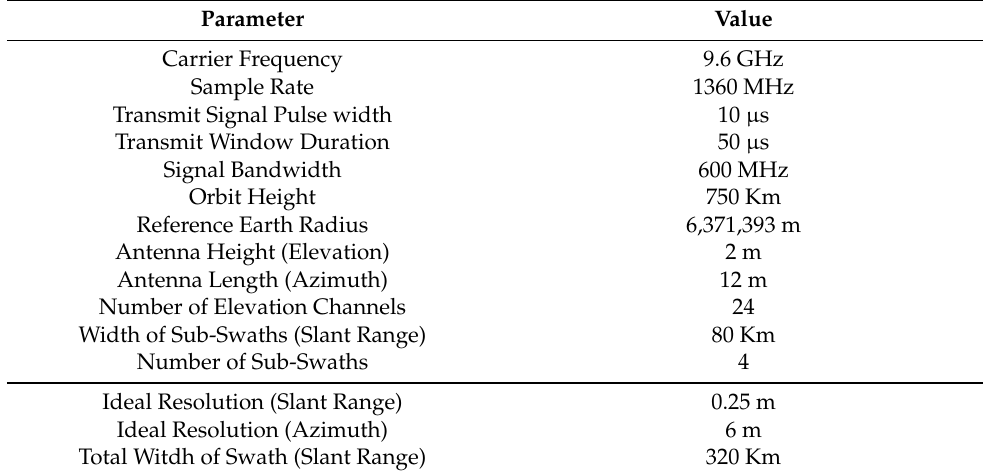
Table 1. Simulation system